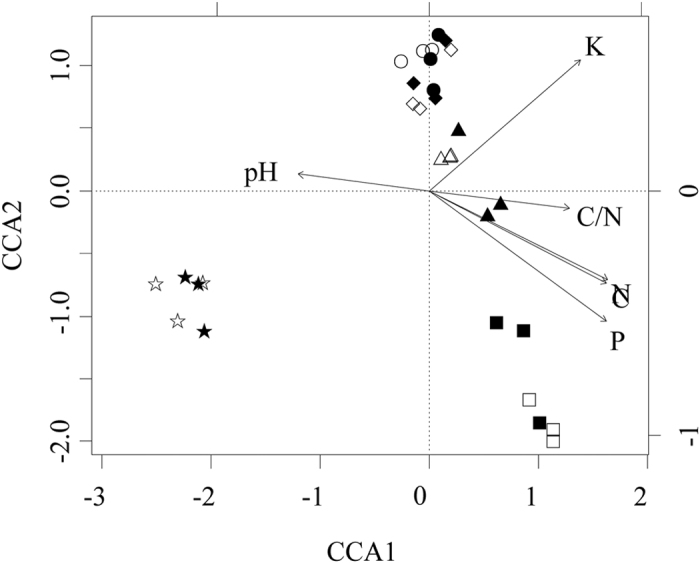
Canonical correspondence analysis (CCA) of sampling sites and soil factors based on Hellinger-transformed fungi OTUs.The land-use types and their icons are as follows: black locust plantation (⦁ and ⚬), oriental arborvitae forest (◆ and ♢), oak forest (◼ and ◻), shrub land (▴ and ▵), and bare land (★ and ☆), in summer and winter respectively. The figure is performed in R v.3.1.3 project (R Development Core Team. 2015), using the R packages vegan.